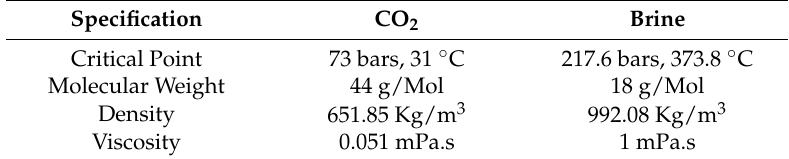
Table 2. Reservoir fluid properties used in the simulation at 150 bars and 55 ◦ C